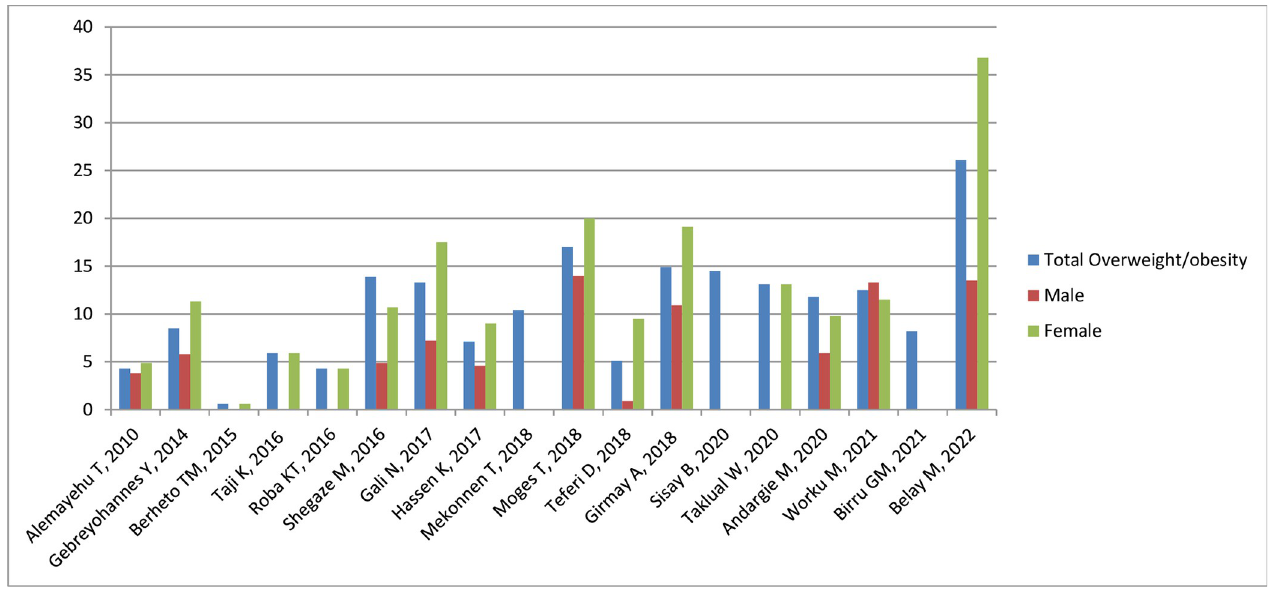
Fig 8. Trends in adolescent overnutrition by sex in Ethiopia over the last 12 years.